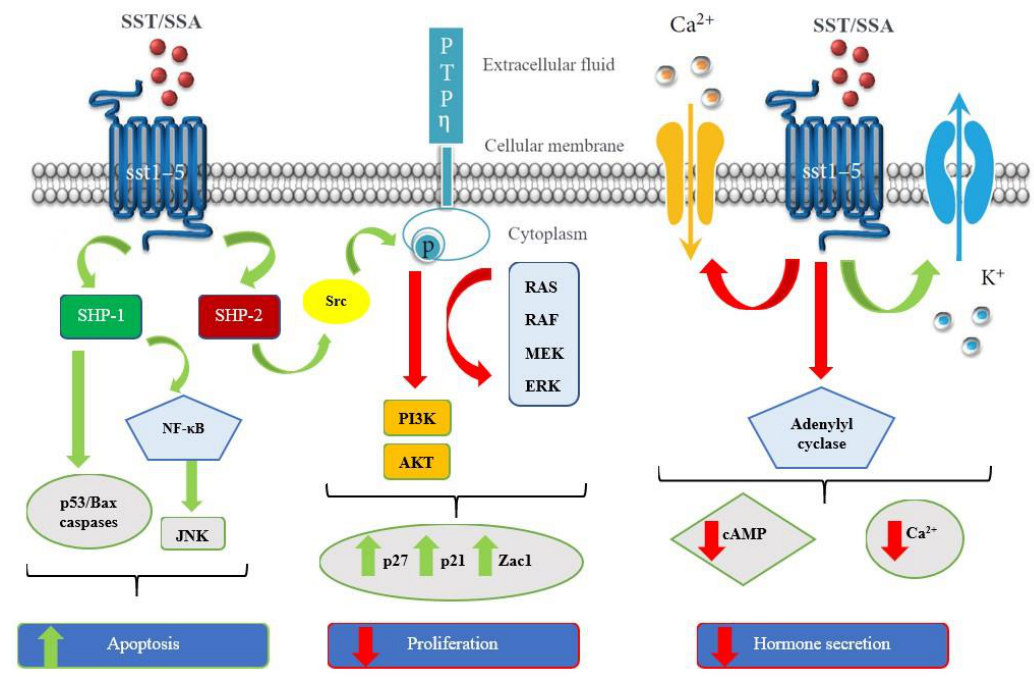
Figure 2. Schematic representation of the signaling pathways induced by somatostatin receptors activation. Green arrows: activated pathways; red arrows: inhibited pathways. Adapted from [8].